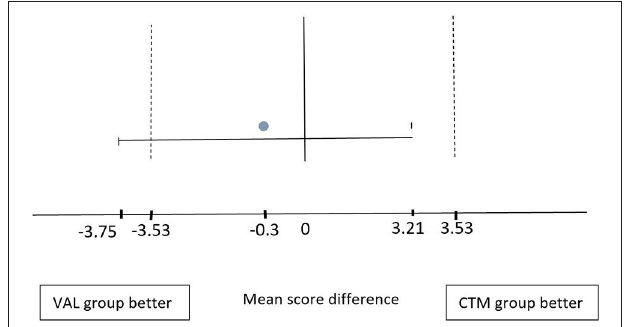
FIGURE 2 | Mean-score difference graph demonstrating that the 10% confidence interval (CI) mean score of the control group is between − 3.53 and 3.53 (dotted line). The absolute difference of the mean score between both groups is negative − 0.3 (gray bullet). The intervention group mean score CI is between − 3.75 and 3.21 (continuous line). The upper bound of CI is within the 10% difference margin. This shows the non-inferiority of the OSCE score of the intervention group compared to control.